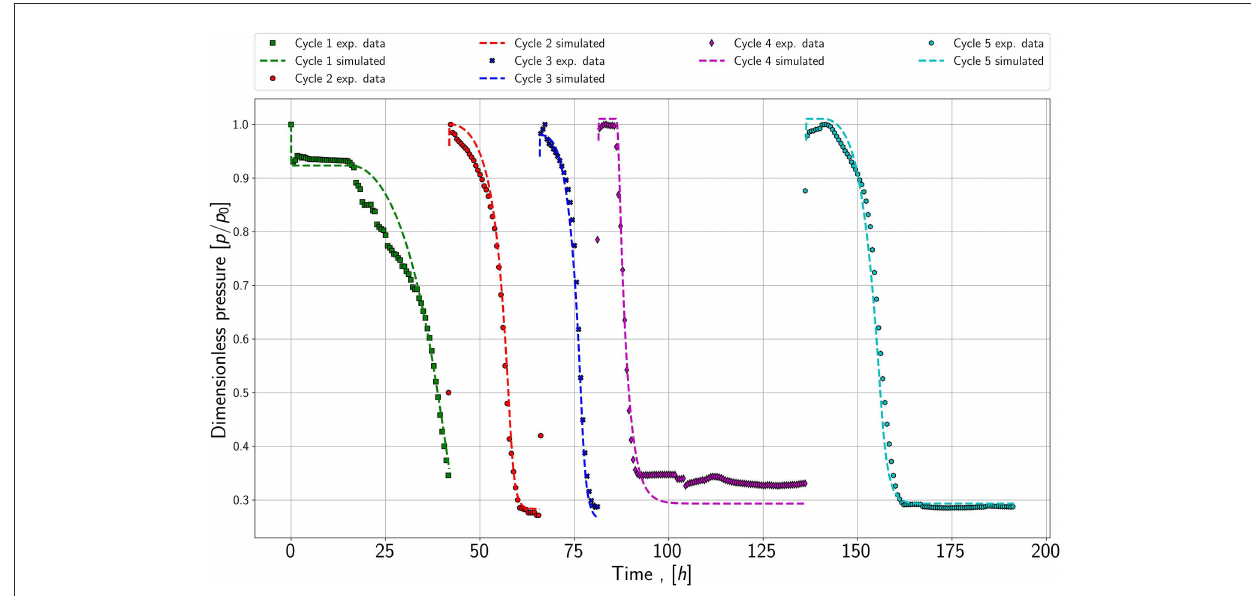
FIGURE6 Simulated pressure versus time and experimental data from the refill